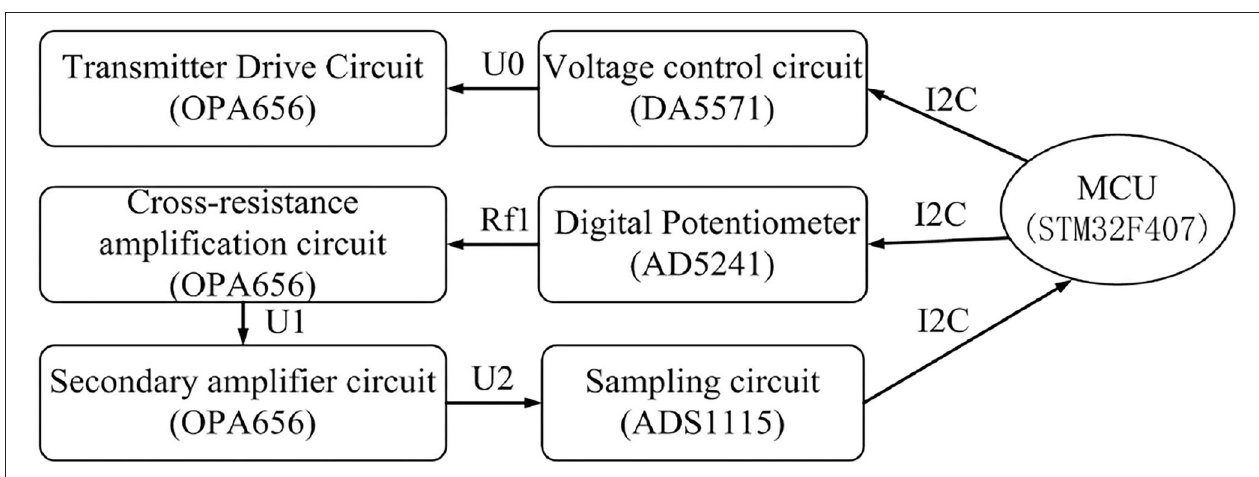
FIGURE 5 | The feedback loop of the fiber acquisition